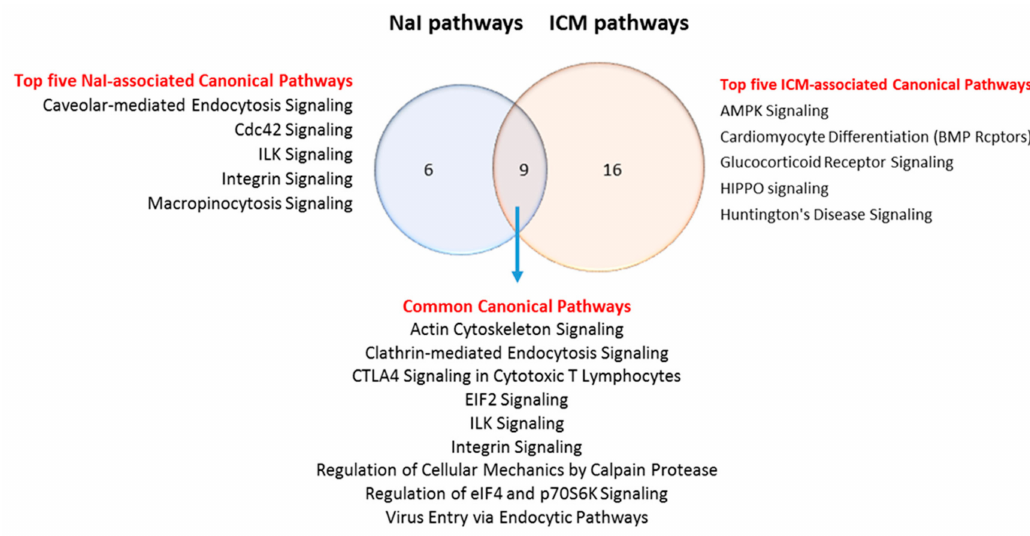
Figure 5. The DEPs in both treatments show up in di ff erent networks, which lead to di ff erent pathways. IPA analysis of the altered pathways shows that ICM treatment leads to 25 pathways while NaI leads to 15 pathways. The Venn diagram illustrates six exclusive pathways in the NaI group versus 16 exclusive pathways analysis in ICM group, with nine pathways being common to both